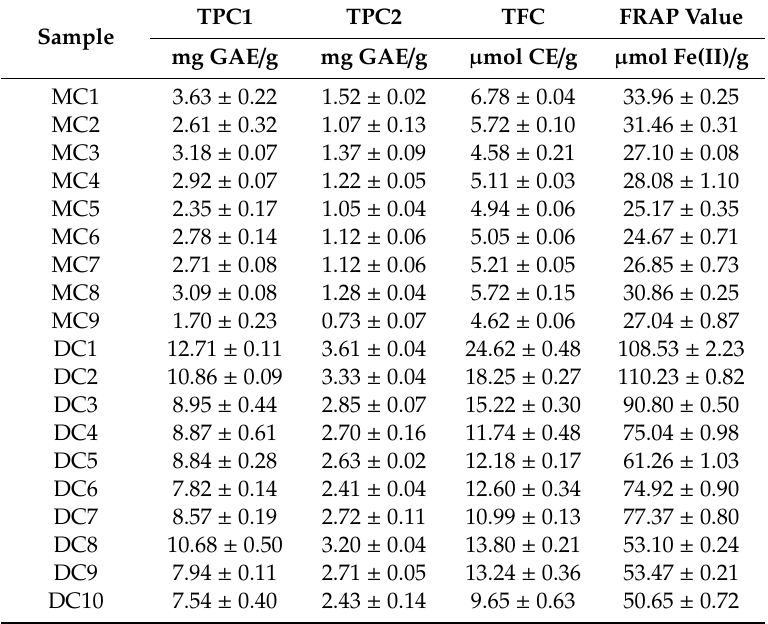
Table 1. Total phenolic (TPC1 and TPC2) and flavonoid (TFC) content and antioxidant capacity (FRAP) of analyzed chocolate samples (average ± standard